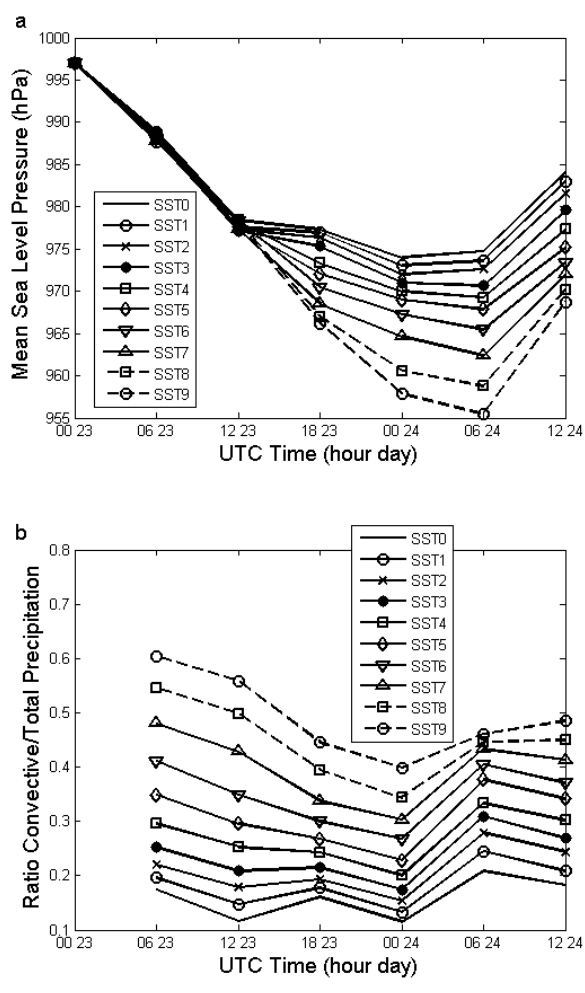
Figure 5. Maximum of 10 m wind speed [ m s -1 ] (a) and ratio con- vective/total precipitation (b) in a domain following Klaus during its evolution as a function of SST anomaly.